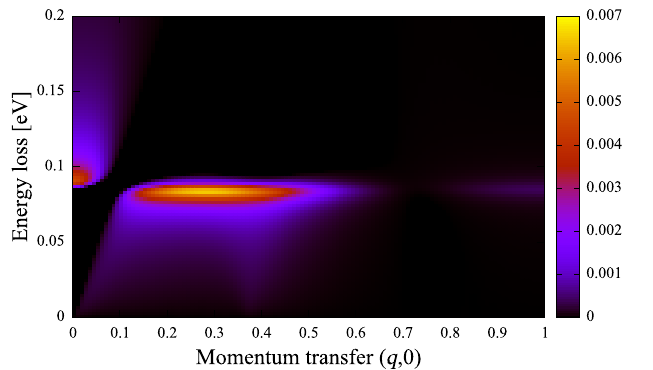
FIG. 8. Apical oxygen phonon contribution to RIXS. Momentum transfer is given in units of π =a .